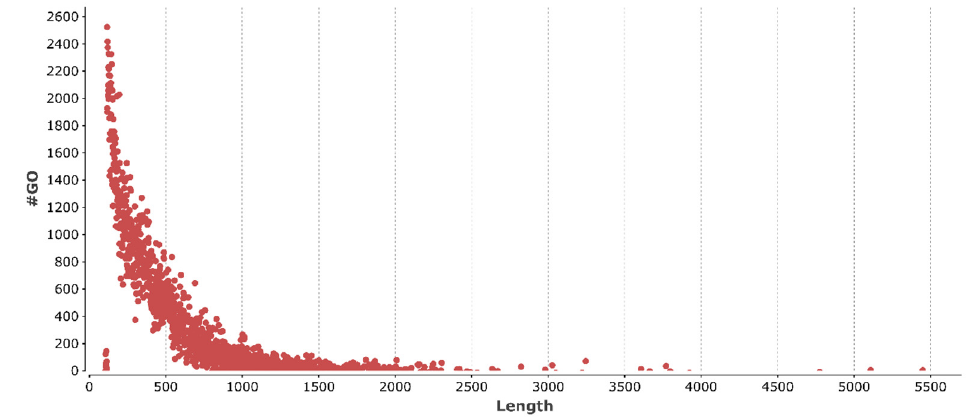
Figure 3. Numbers of GO terms relative to sequence length in the transcriptomes of tree tomato accessions A21 and A23.